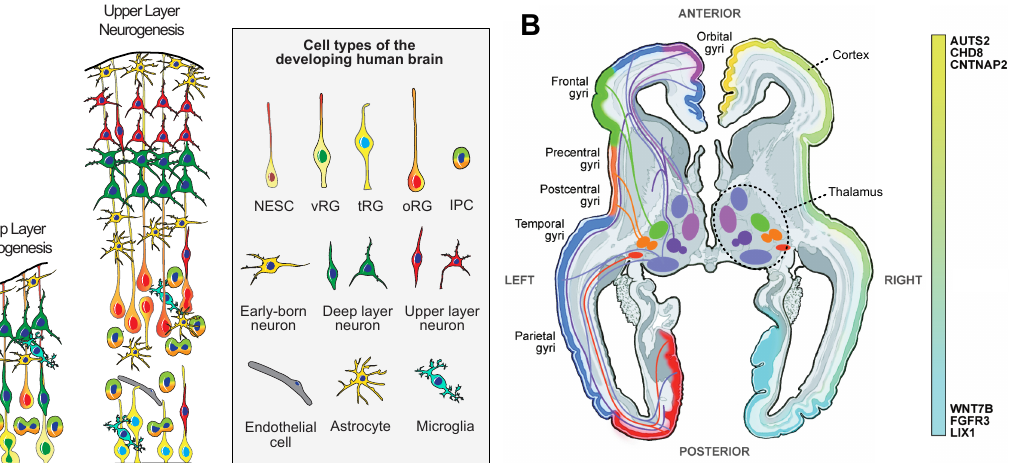
Figure 2. Development of the human brain. ( A ) Schematic representation of the key cellular populations during stages of peak neurogenesis and early gliogenesis in the human cerebral cor- tex. NESC—neuroepithelial stem cells, vRG—ventricular radial glia, tRG—truncated radial glia, oRG—outer radial glia, IPC-intermediate progenitor cells. ( B ) Development of the long-range con- nectivity between prospective subdivisions of the thalamus and cortical areas. The schematic shows a horizontal section through a developing human brain. The left half highlights major projection path- ways between the emerging thalamic nuclei and cortical areas. The right half highlights differences in expression levels of specific genes with rostro-caudal expression